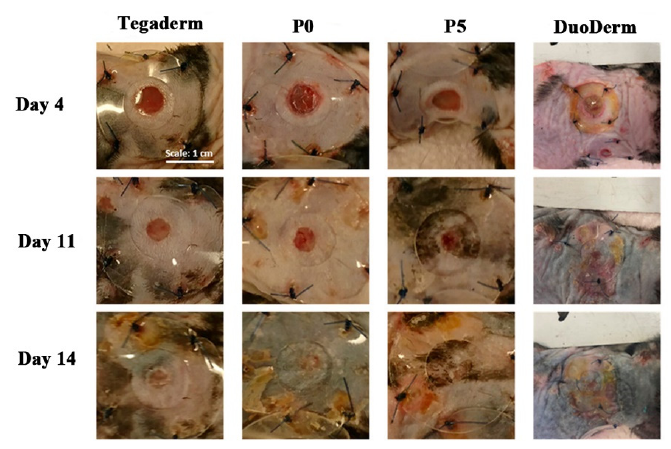
Figure 2. Photos of diabetic wounds treated with P5 fiber membranes at 4, 11, and 14 d. Reproduced with permission from [65] , ACS, 2021. with permission from [65], ACS,